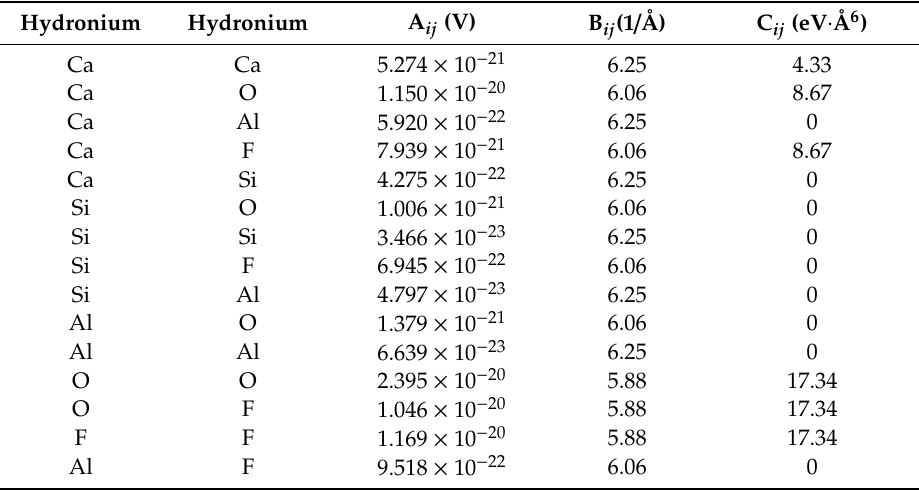
Table 4. Parameter values of BMH potential